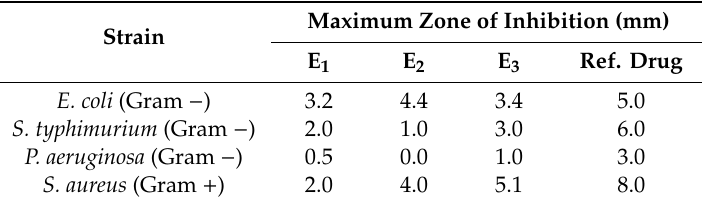
Table 1. Maximum zone of inhibition induced by Ag 2 Se NP samples calculated (in mm) for Gram − and Gram +